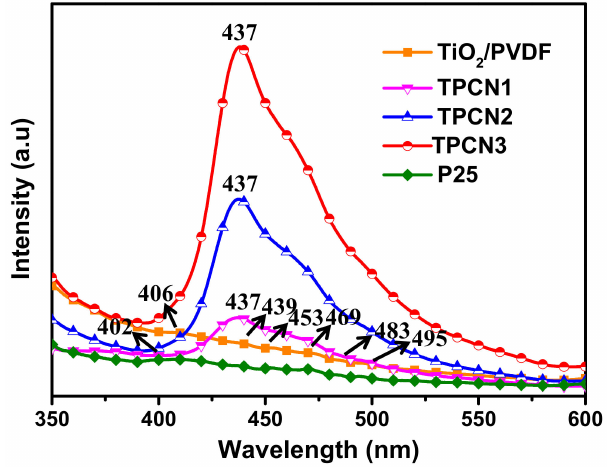
Figure 5. Photoluminescence (PL) spectra of TiO 2 / PVDF, P25 ® and various as-prepared TPCN